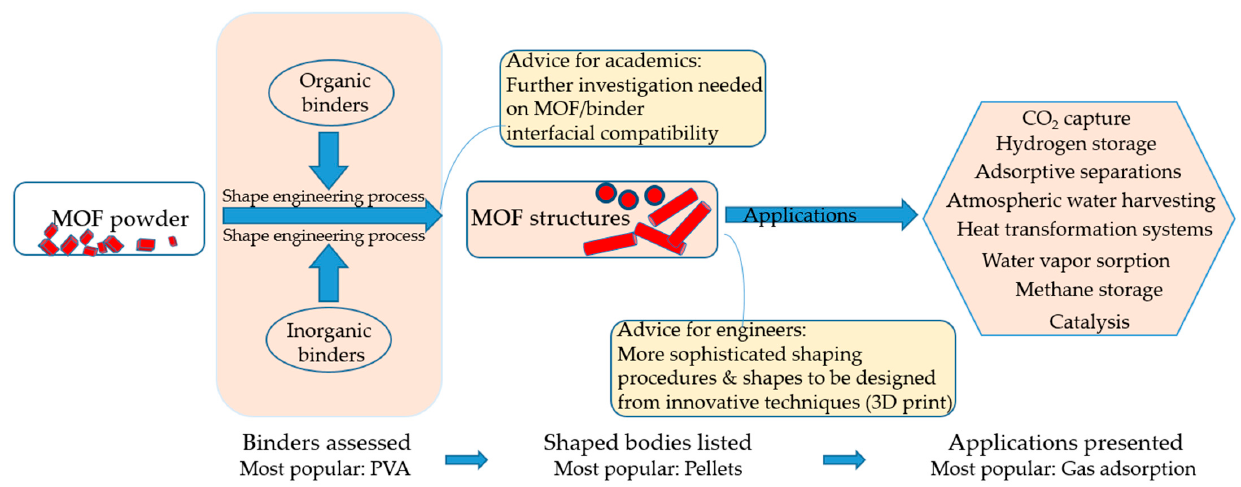
Figure 6. Conclusions scheme.